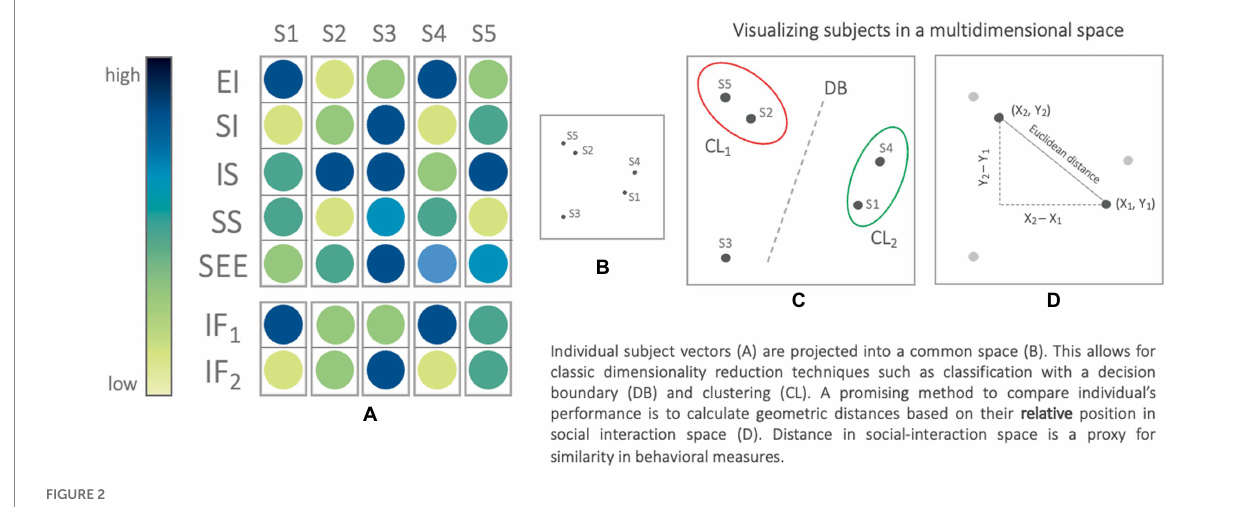
FIGURE 2 Schematic demonstrating the process of using individual vectors derived from measures of social performance (A) to create a social performance space (B) in which individuals can be clustered (C) or compared (D) using Euclidean